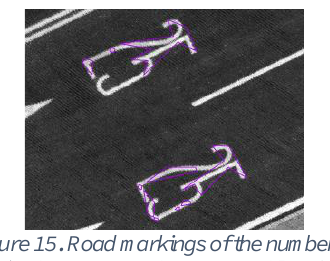
Figure 15. Road markings of the number 25